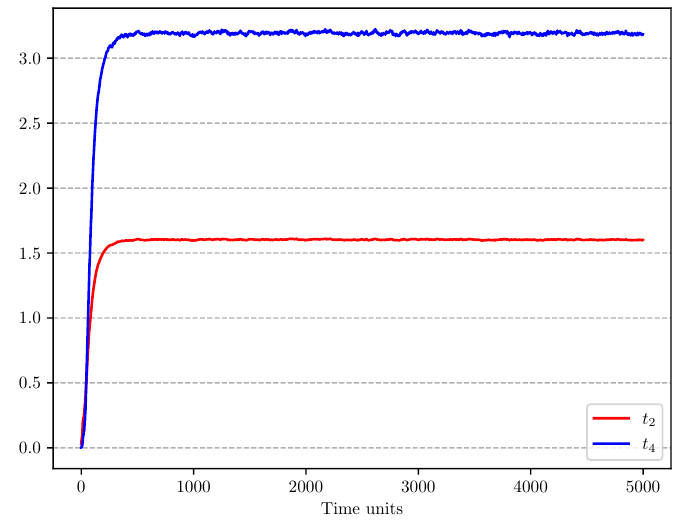
Figure 12: We find that two matrices have common t = 1.037 ( 3 ) . This is for g = 1, c = 1.35, κ = 0 and N = 300 for the model with t 2 three matrices. We have computed errors after discarding the first 1000 time units in this case.